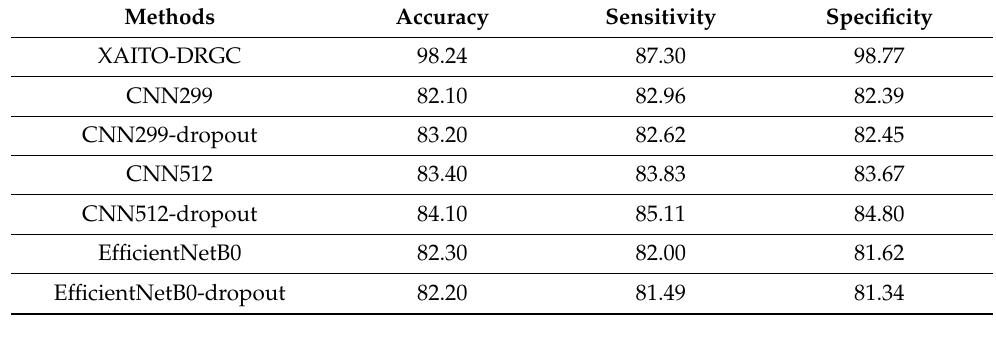
Table 5. Comparative analysis of the XAITO-DRGC approach with recent methods on the DDR dataset.